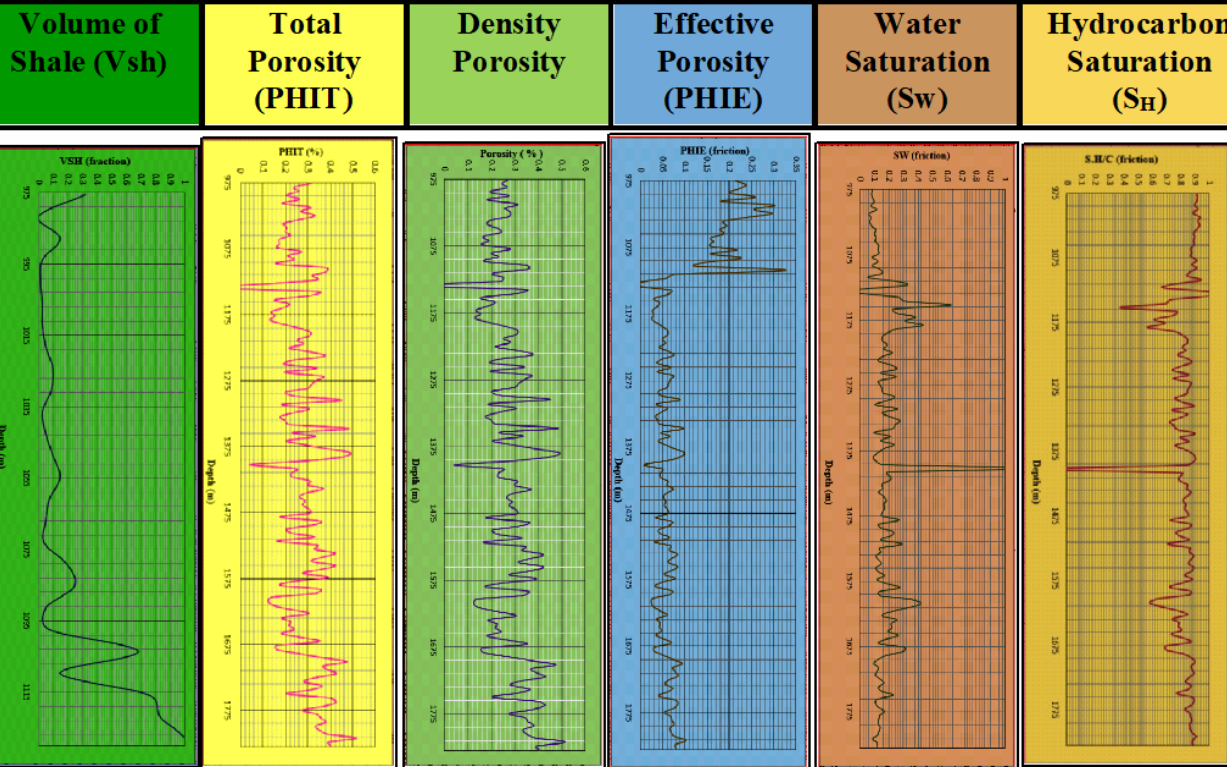
Figure 23. Combined well logs.